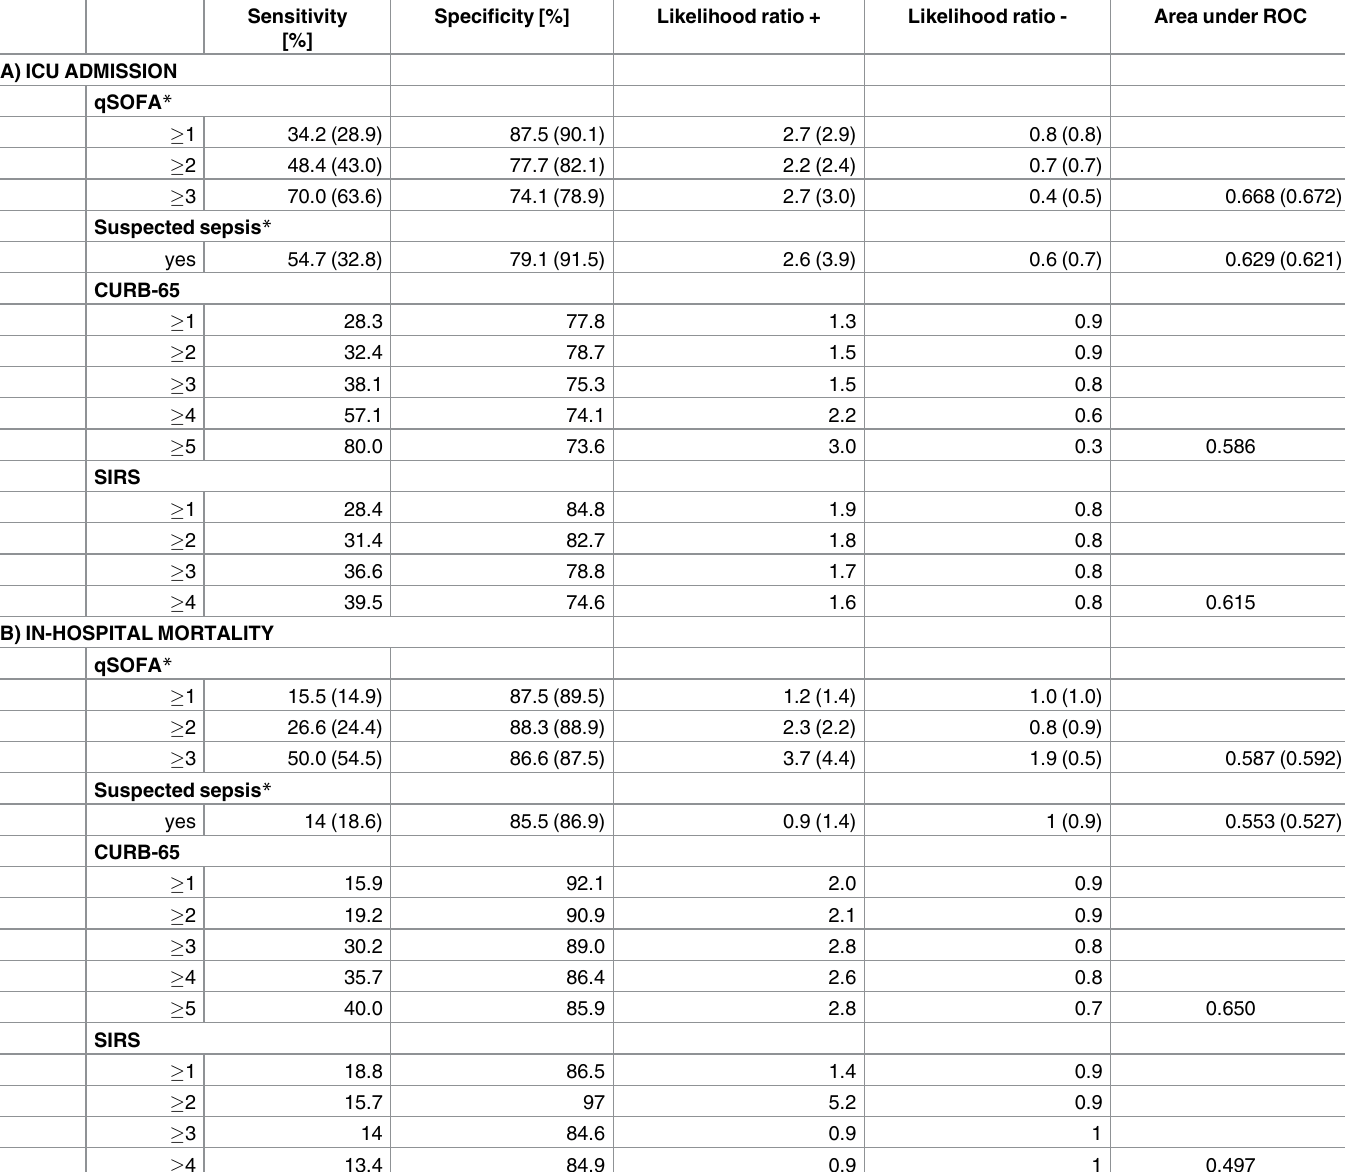
Table 4. Diagnostic performance of different scores predicting A) ICU admission and B) In-hospital mortality (n = 346). Sensitivity Specificity [%] Likelihood ratio + Likelihood ratio - Area under [%]